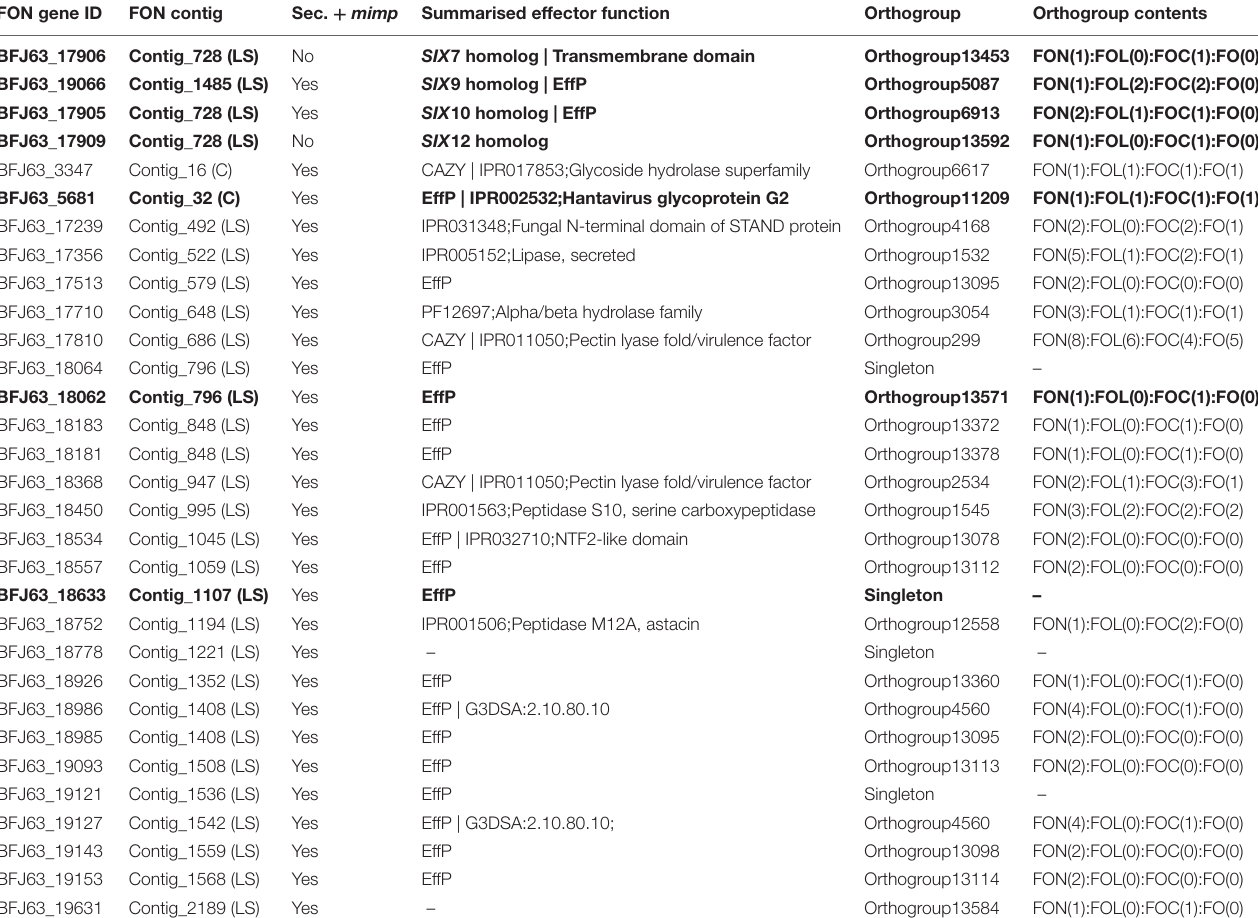
TABLE 3 | Details of SIX gene homologs and an additional 27 genes in the FON genome located within 2 kb of mimps and encoding predicted secreted proteins (Sec + mimp ). FON gene ID FON contig Sec. + mimp Summarised effector